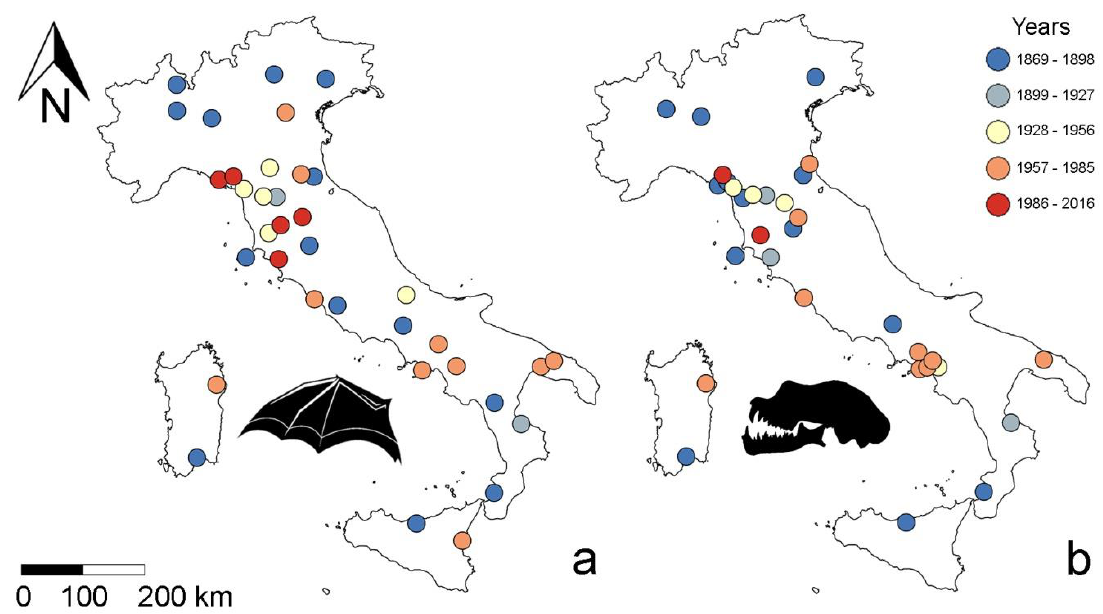
Figure 1. Geographic distribution of Rhinolophus hipposideros specimens from Italian populations considered for analysis after removing all spatially autocorrelated records. ( a ) Forearms: N = 36; ( b ) skulls: N = 31.